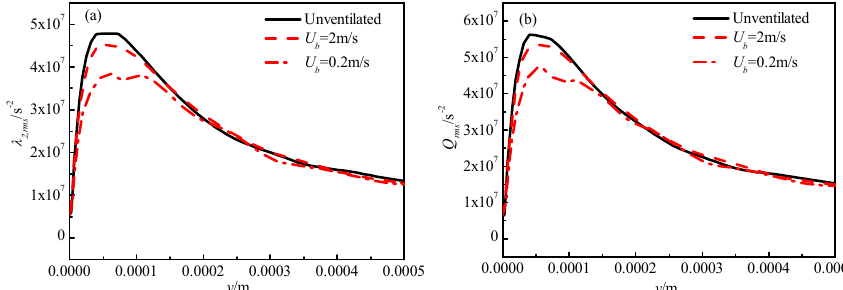
Figure 15. ( a ) Average distribution of the root mean square of λ 2 along the normal direction and ( b ) average distribution of root mean square of Q along the normal direction.